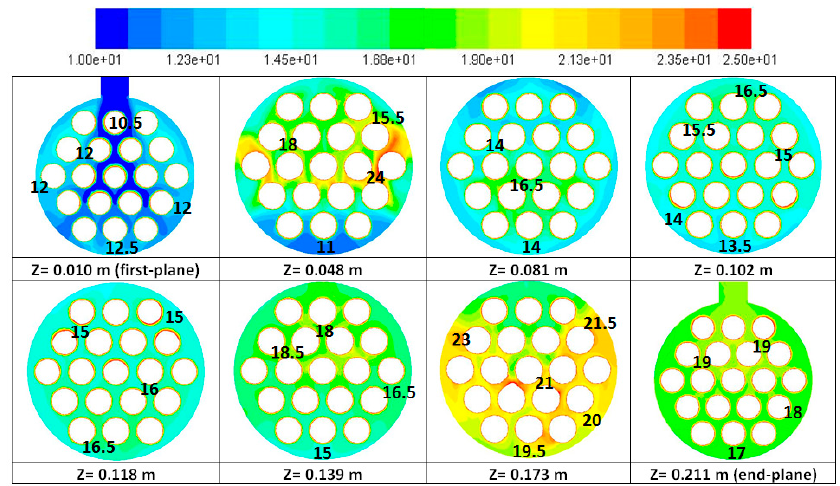
Figure 10. Prediction of temperature (°C) distribution at section planes defined in shell side (Case-I).